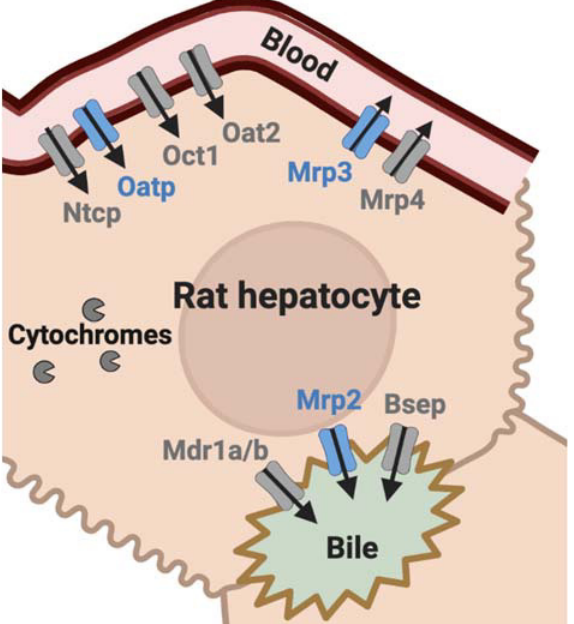
Figure 1. Membrane transporters expressed in rat hepatocytes. Transporters known to be involved in the hepatobiliary transport of 99m Tc-mebrofenin are highlighted in blue. Bsep: bile salt export pump; Mdr: multidrug resistance; Mrp: multidrug resistance-associated protein; Ntcp: Na+-taurocholate co- transporting polypeptide; Oat: organic anion transporter; Oatp: organic anion-transporting polypep- tide; Oct: organic cation